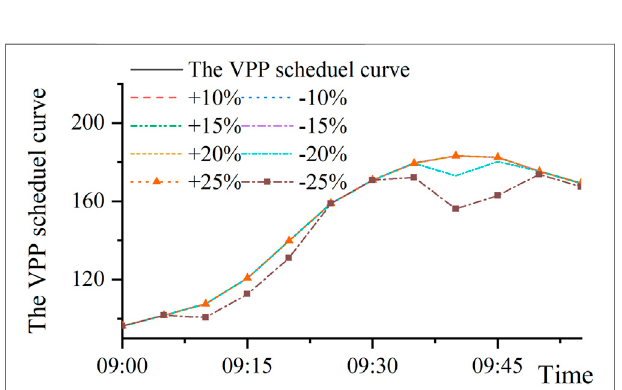
FIGURE 6 | (A) The real-time forecasting power (B) The VPP real-time DED performance.